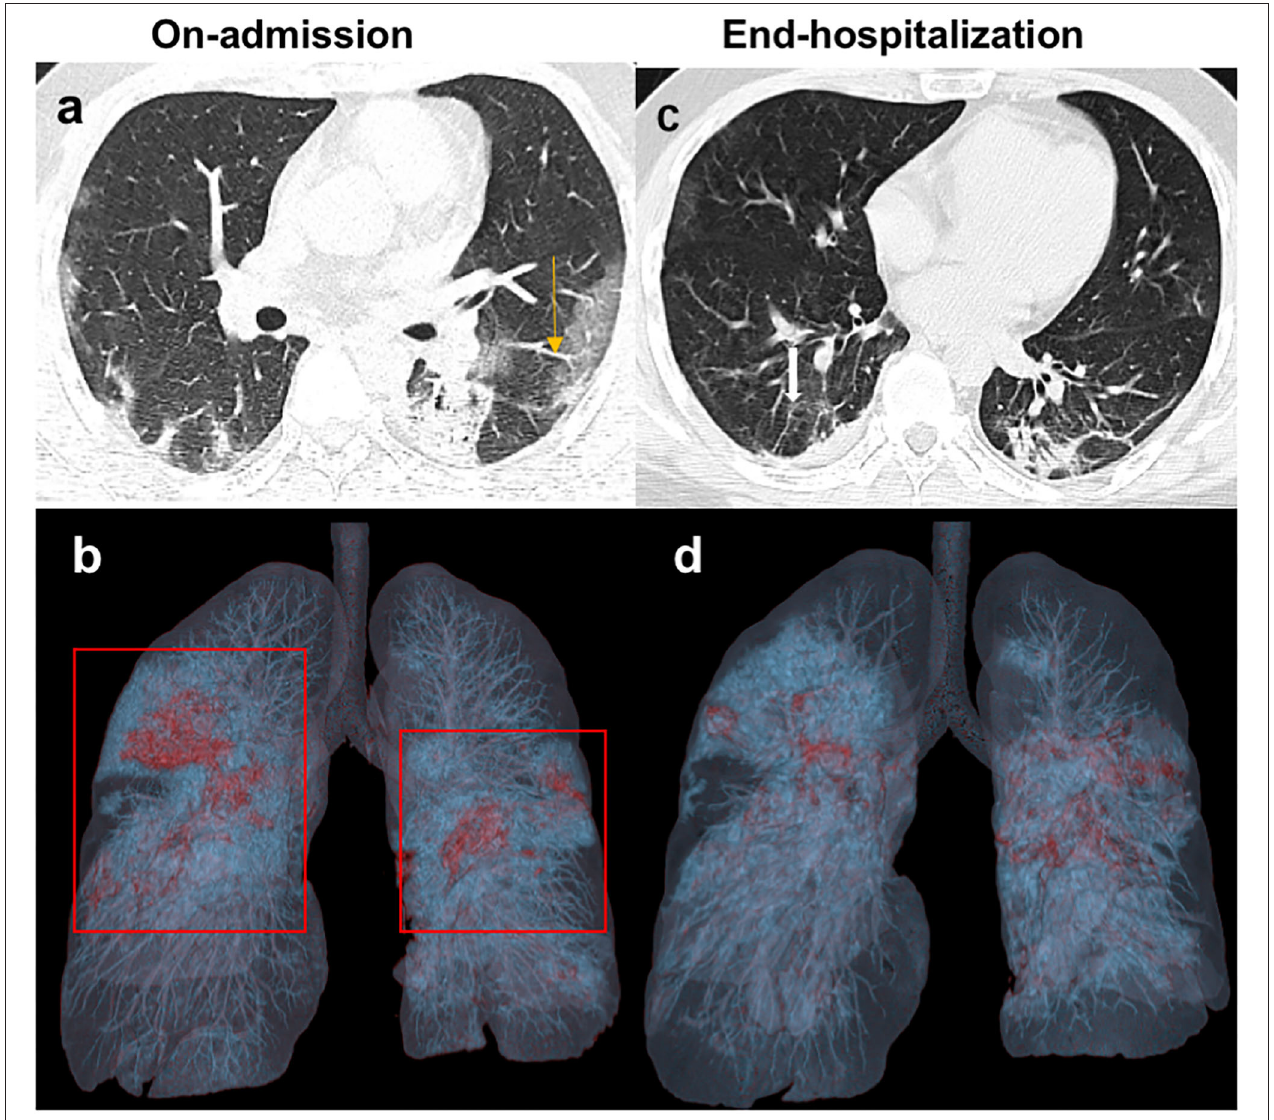
FIGURE 2 | Unenhanced chest CT images of a 32-year-old man with COVID-19 infection from FC group. (a) Axial image on-admission shows the mixed pattern of multifocal bilateral GGO and consolidation in the subpleural regions of the lungs. The enlarged pulmonary vessels also could be seen (yellow arrow). (b) 3D-VR image of chest CT scan on-admission presents as red and blue dense lesions (red box). (c) At the end of hospitalization, follow-up CT shows the consolidation evidently resolved with residual irregular linear opacities (white arrow). (d) The previous red and blue dense lesion in the 3D-VR image was absorbed